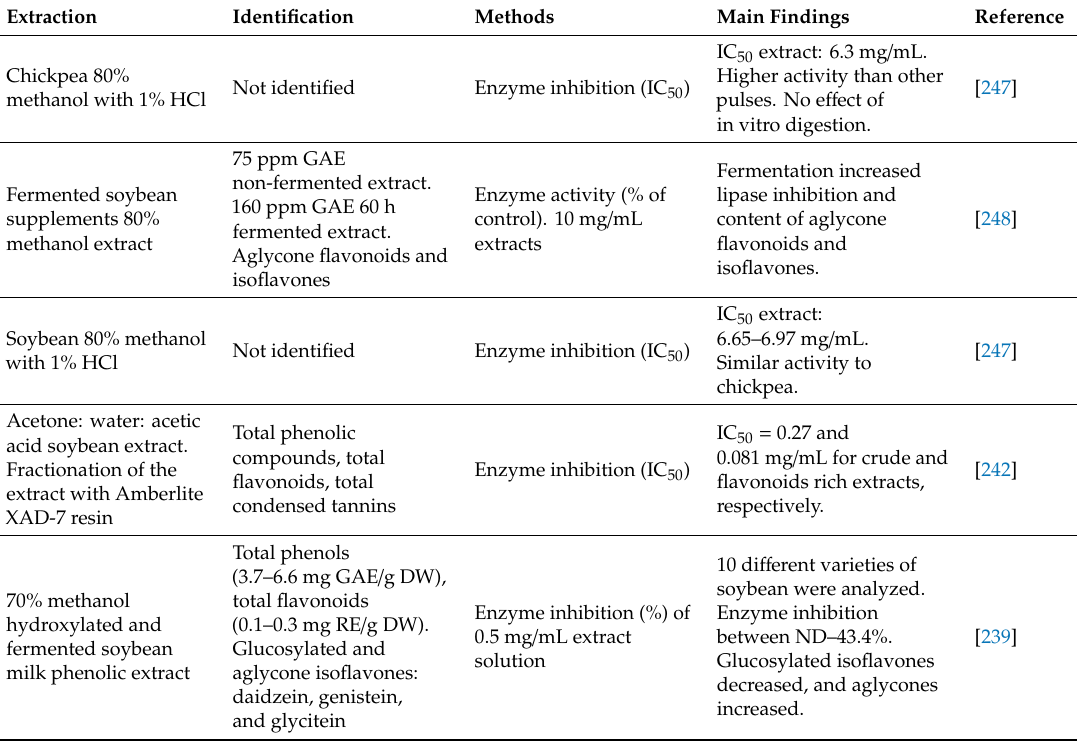
Table 7. Inhibition of α -glucosidase by soybean and chickpea phenolic extracts.